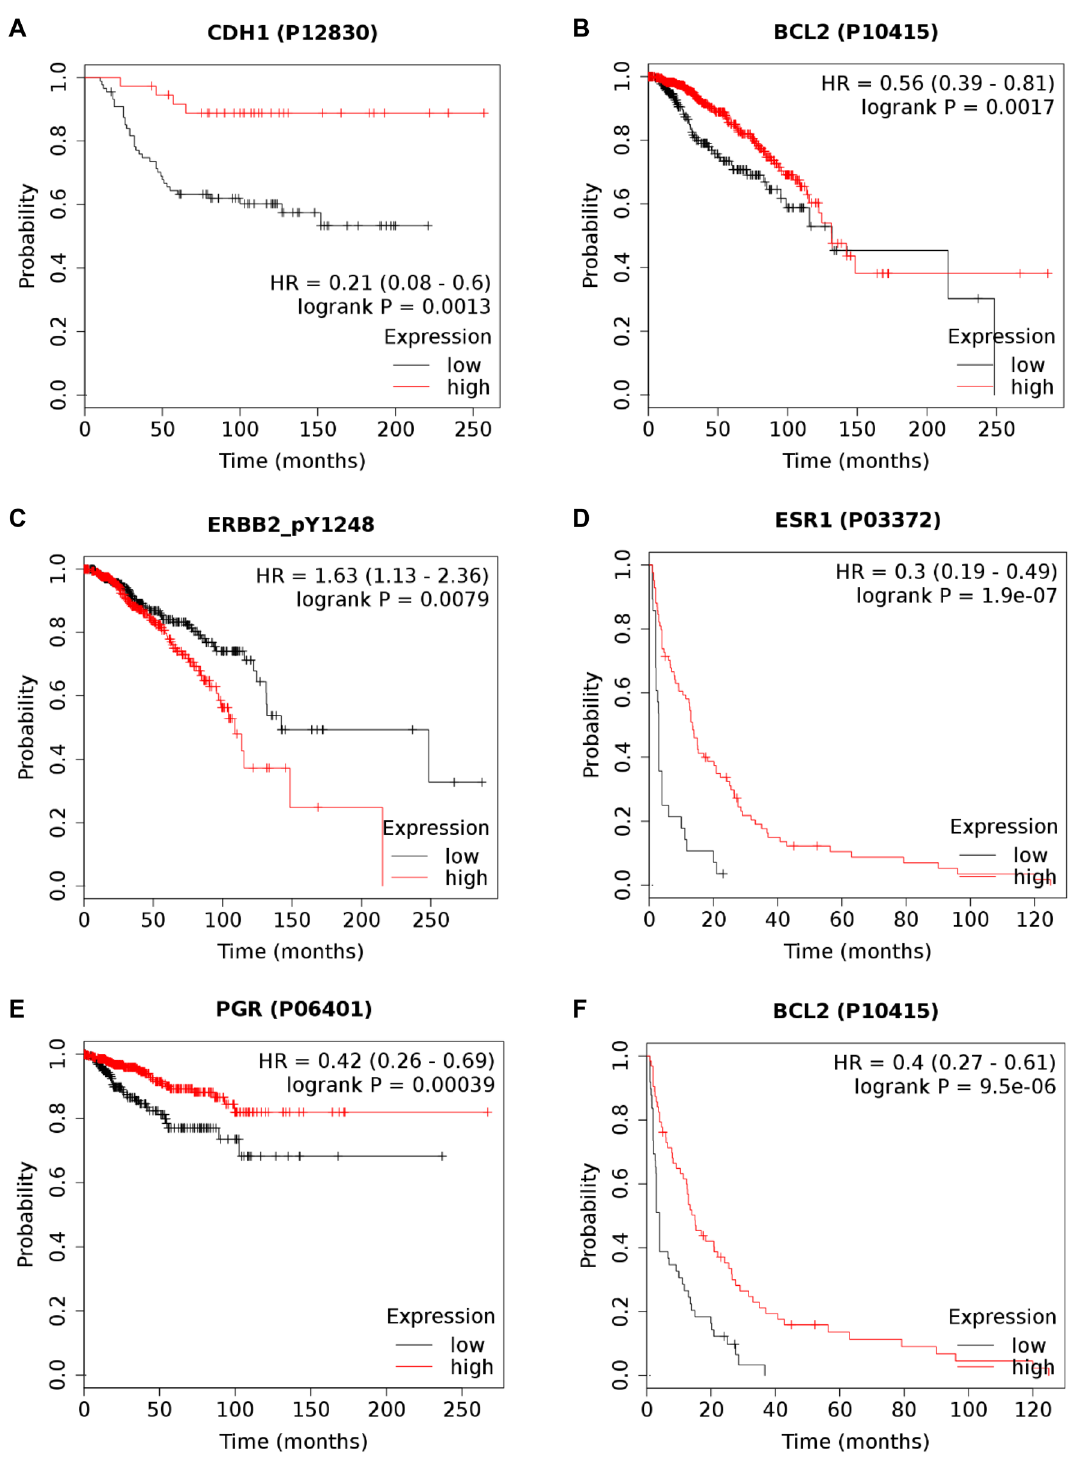
Figure 6. Survival outcome differences in patients with different expression levels of protein biomarkers. Kaplan–Meier plots of overall survival by CDH1 (E-cadherin) ( A ), apoptosis regulator BCL2 ( B ), and tyrosine 1248-phosphorylated HER2 ( C ). Kaplan–Meier plots of relapse-free survival for estrogen receptor 1 ( D ), progesterone receptor ( E ) and BCL2 ( F ) in breast cancer patients. Note the different survival characteristics of the different